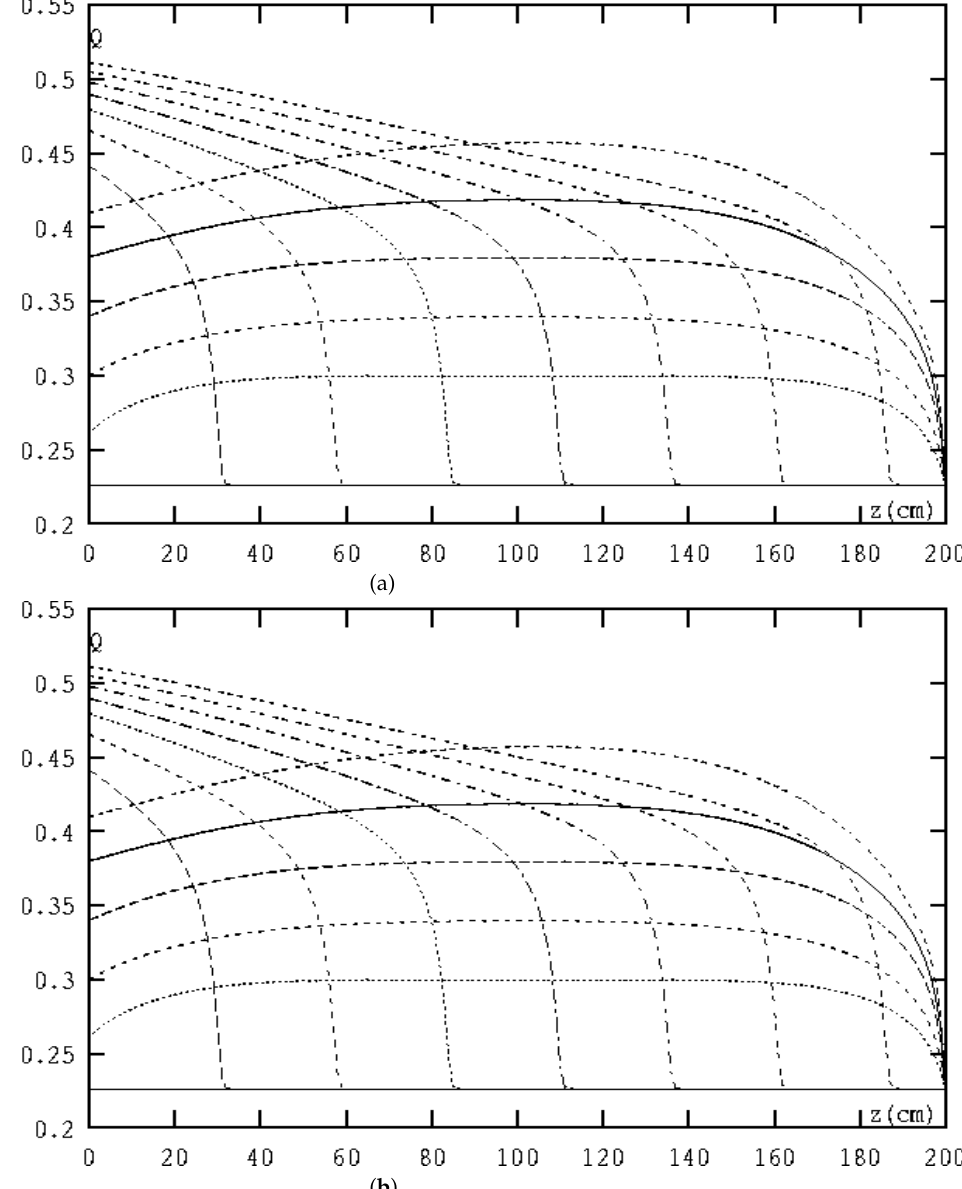
Figure 3. ( a ) These curves are the PPMFERD solutions of infiltration and evaporation water content at t = 60 h, 120 h, . . . , 420 h, 480 h, . . . , 840 h, respectively. ( b ) These curves are the classical MFE solutions of infiltration and evaporation water content at t = 60 h, 120 h, . . . , 420 h, 480 h, . . . , 840 h,